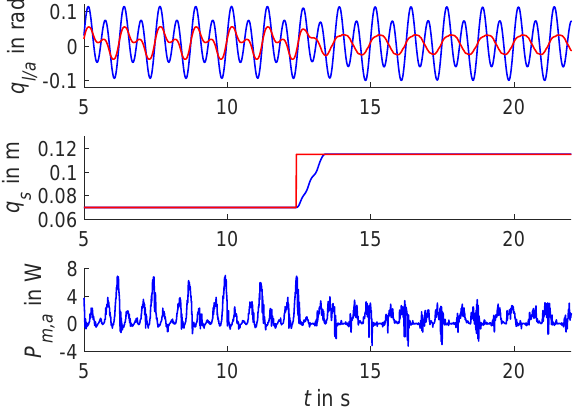
Figure 10. Adjustment to antiresonance while tracking a dual sinusoidal trajectory with 0.8Hz and 1.6Hz; link (blue) and actuator (red) positions in upper plot, desired (red) and current (blue) counter bearing positions middle plot, mechanical power in lower plot.